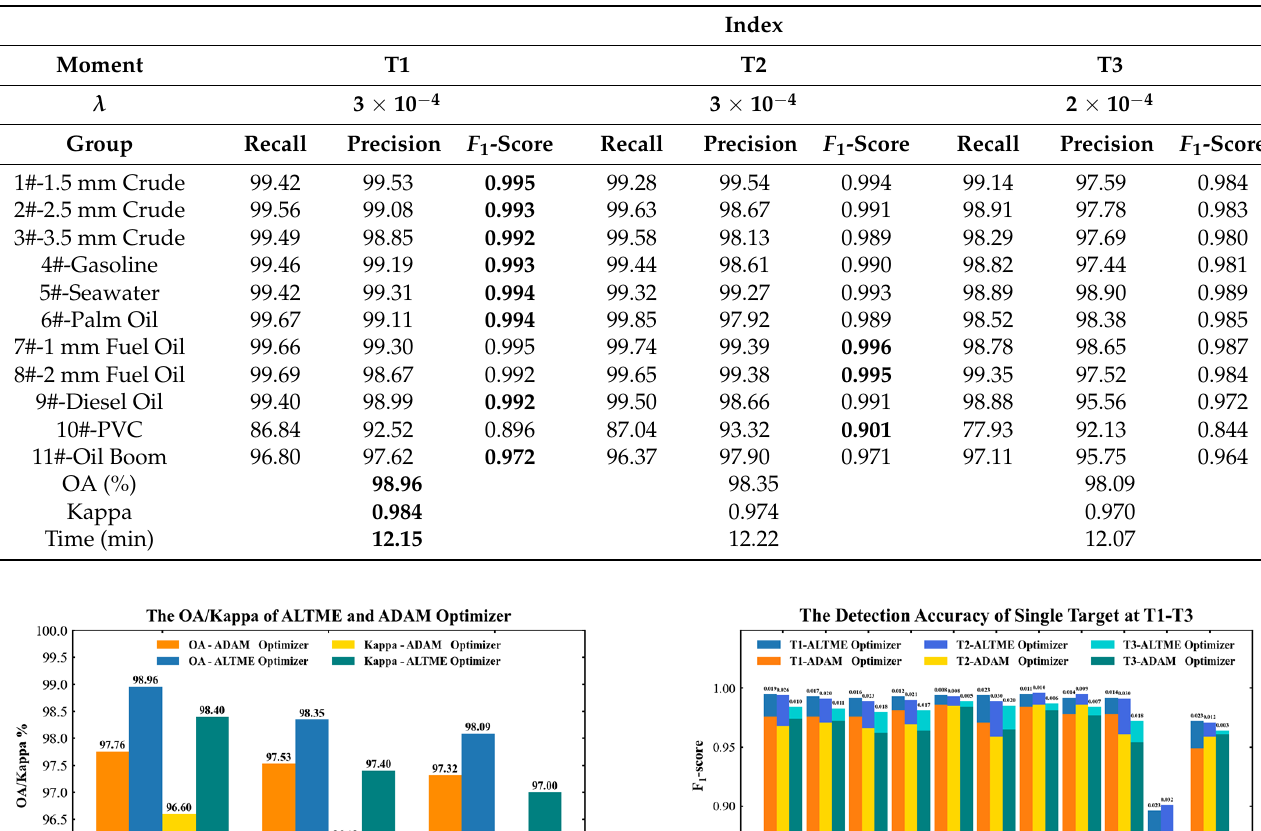
Table 8. Accuracy of the adaptive selection of the cumulative learning weight at T1-T3.